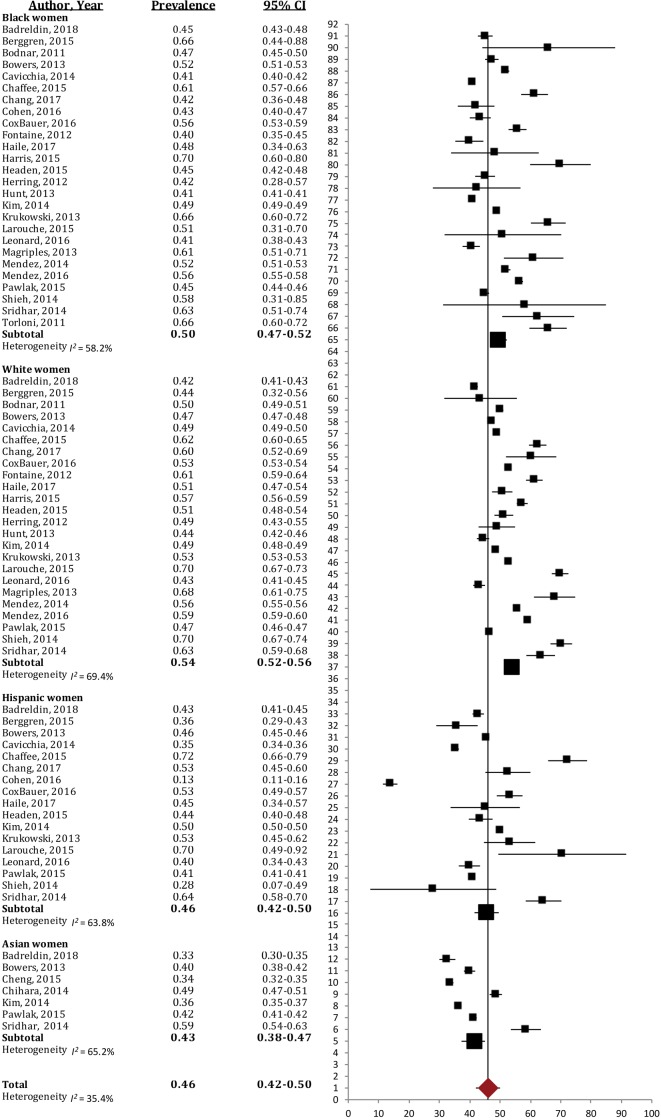
Forest plot of the prevalence of excessive gestational weight gain in Black, White, Asian and Hispanic women.The prevalence of women exceeding the 2009 IOM gestational weight gain guidelines, broken down by racial/ethnic groups. Large black sqaure represents the weighted prevalence in each group.